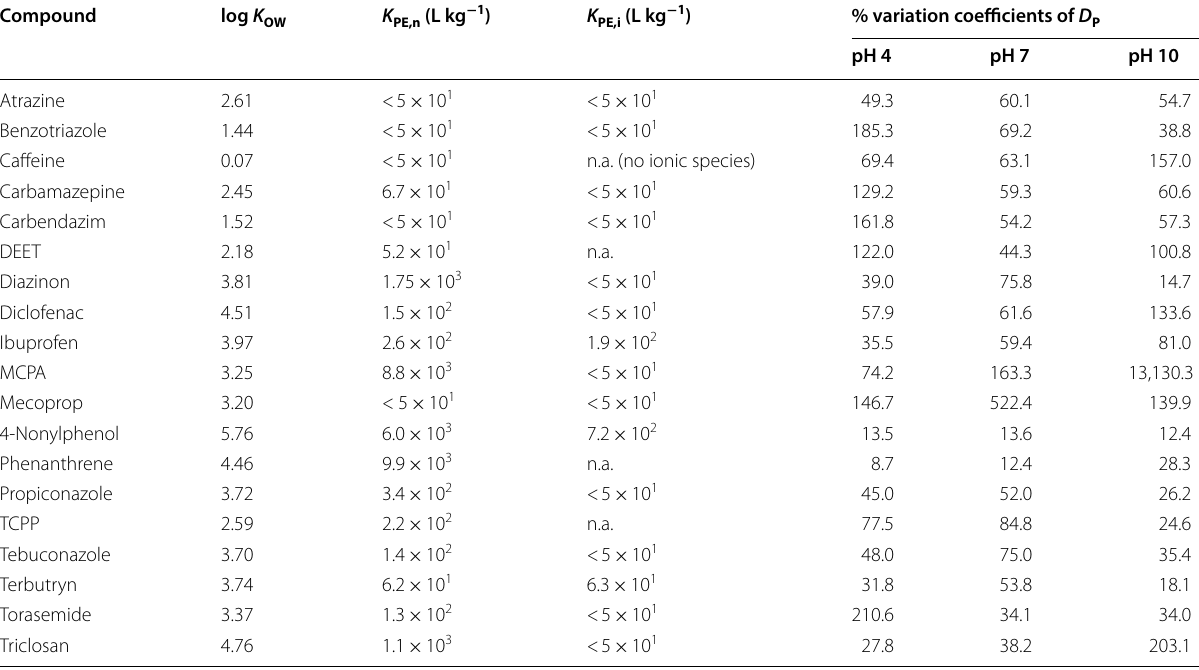
K values below 50 L kg − 1 are not reported due to too large uncertainties